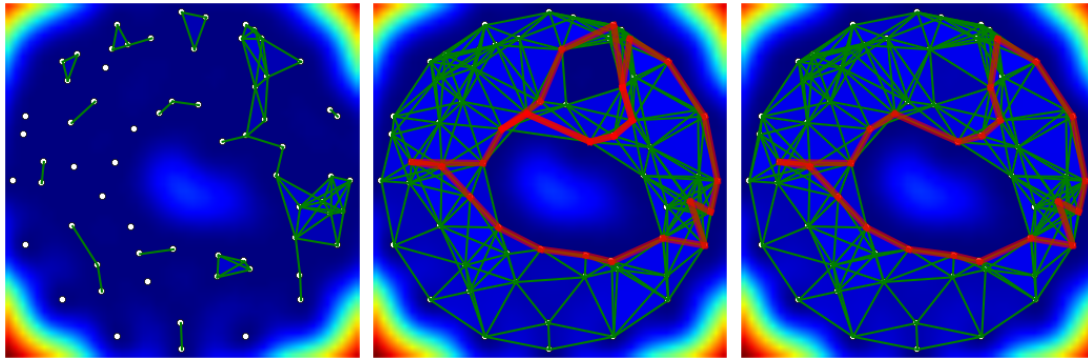
Figure 10. Detection of holes in the coverage by online correlation